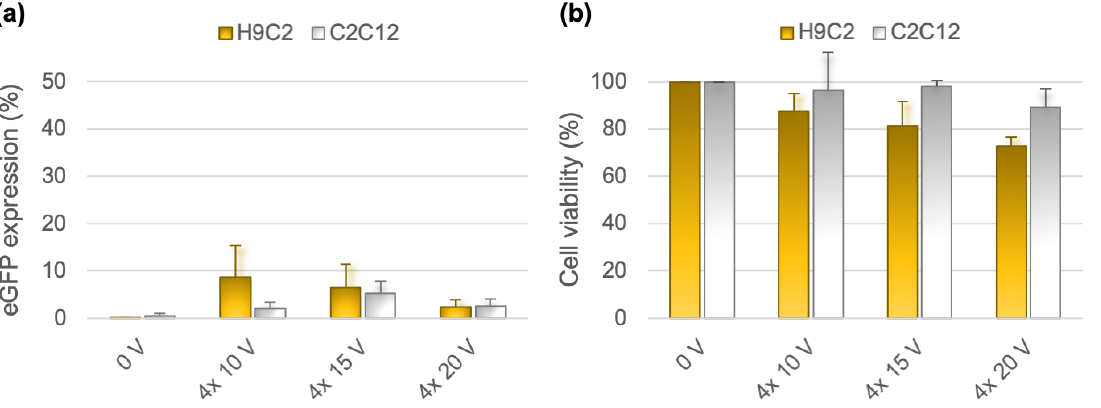
Figure 6. Transfection efficiency and cell survival in H9C2 and C2C12 cells. Experiments were per- formed in the same way as for CHO cells, but only using membranes with 0.4 µm substrate pores. ( a ) Percentage of cells expressing eGFP. ( b ) Percentage of viable cells. Graphs show mean ± s.d. from 3–4 experiments.